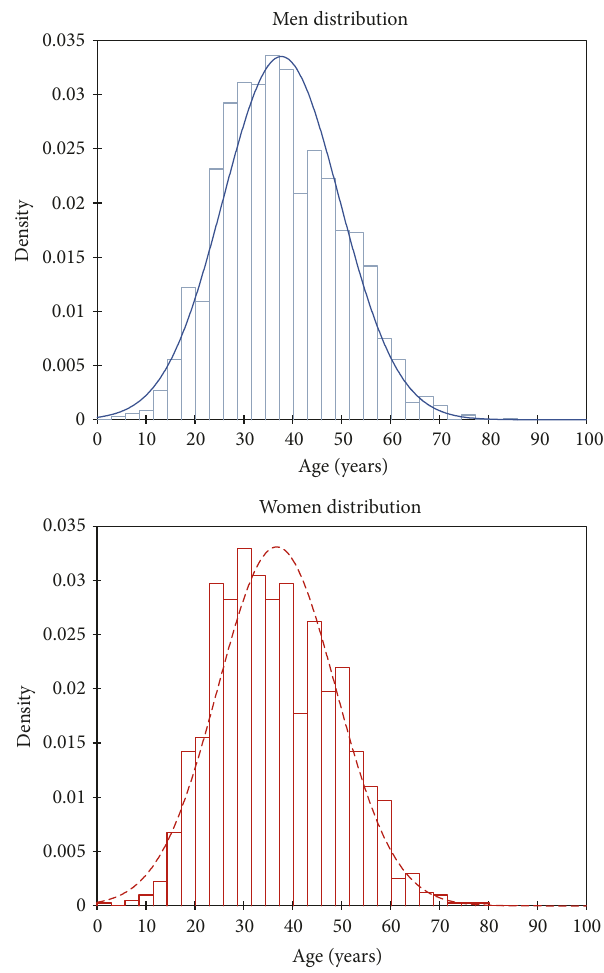
Figure 2: Age-based distribution of patients followed at CILM according to their gender (blue: male; red: